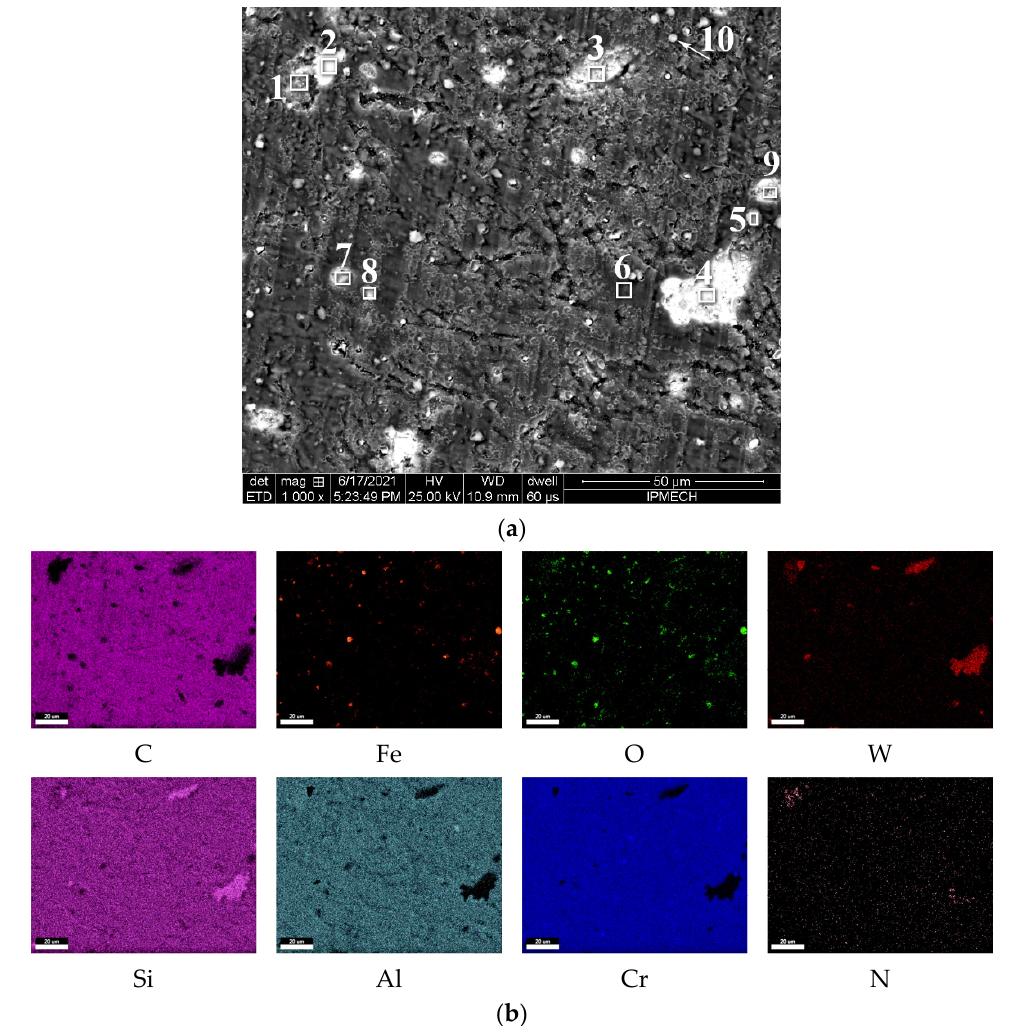
Figure 5. Image of the sample surface in area 3 in the middle zone of the friction track: ( a )—zones of X-ray spectral analysis, ( b )—maps of the distribution of chemical elements. Table 4. Elemental composition of the sample surface in area 3 in the middle zone of the friction track. Content of Element, wt.% Zone